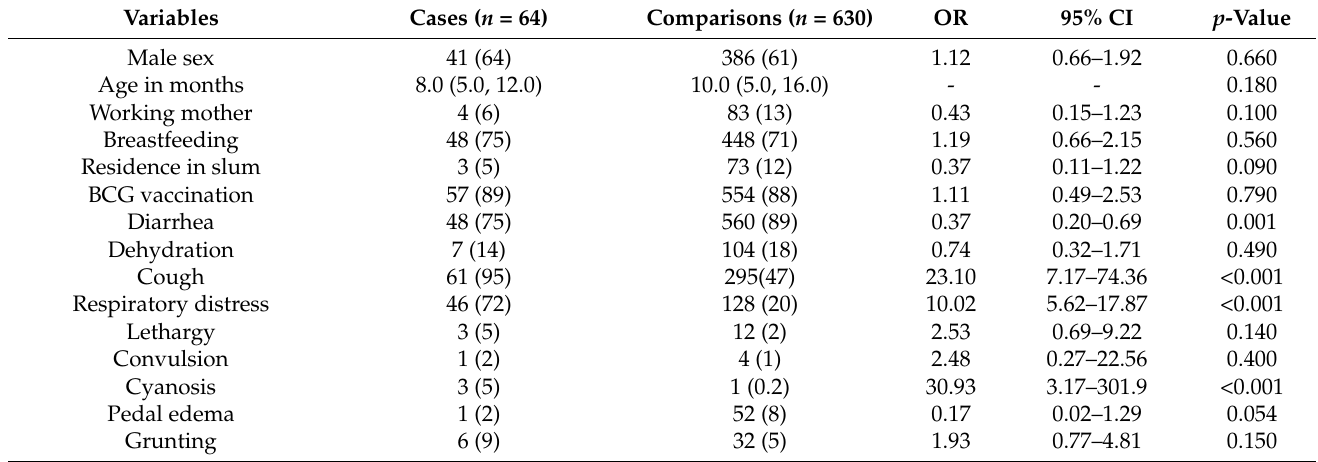
Table 1. Characteristics of children between cases and comparisons at